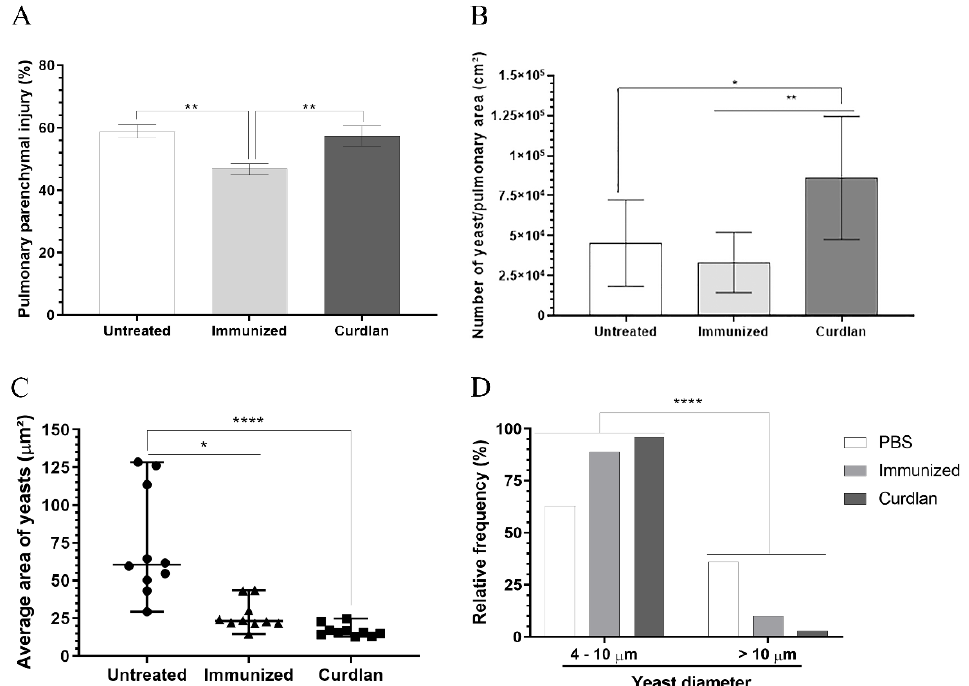
Figure 8. Morphometric analysis of the lung tissue in BALB/c mice treated with curdlan, immunized with HK- C. gattii , and infected with viable C. gattii . Lungs were perfused with PBS and harvested from the BALB/c mice 14 days post infection. Lung fragments were fixed with methacarn, dehydrated in an alcohol battery, diaphanized with xylol, and embedded in paraffin. Serial 5 µm cuts were made and stained with Grocott-Gomori methenamine silver (GMS). ( A ) Pulmonary parenchyma injury (%), ( B ) quantification of the number of yeast cells/pulmonary area (cm 2 ), ( C ) average yeast cell area (µm 2 ), and ( D ) yeast relative frequency were evaluated in a semi-automated quantitative way using ImageJ Fiji. The data were analyzed using the X 2 test (Goodness-of-fit test). Values were expressed as mean ± SD. * p < 0.05, ** p < 0.01, and **** p < 0.0001.